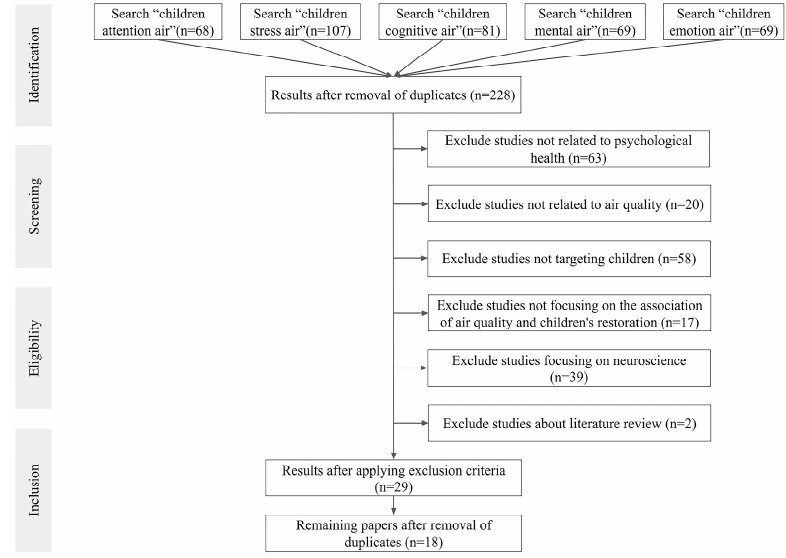
Figure 2. The Systematic Literature Search with Inclusion and Exclusion Criteria. Table 4. Extracted Data of Included Literature.